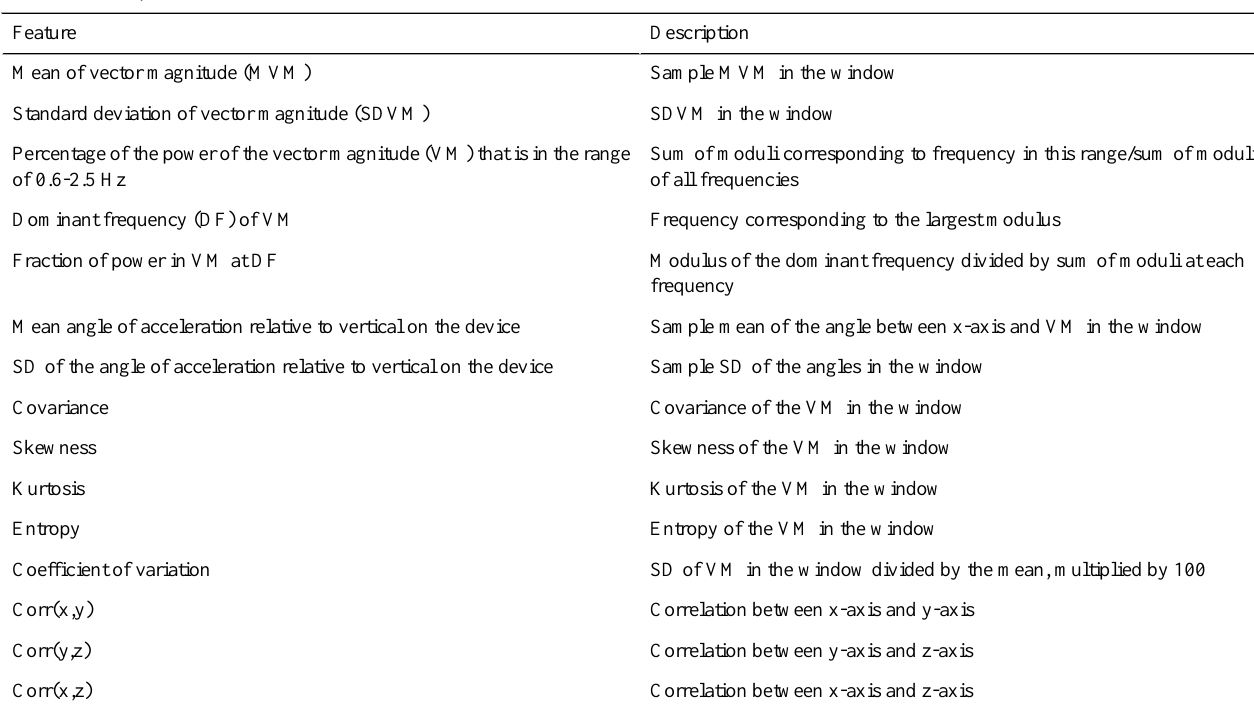
Table 3. Description of the features extracted from the raw data.